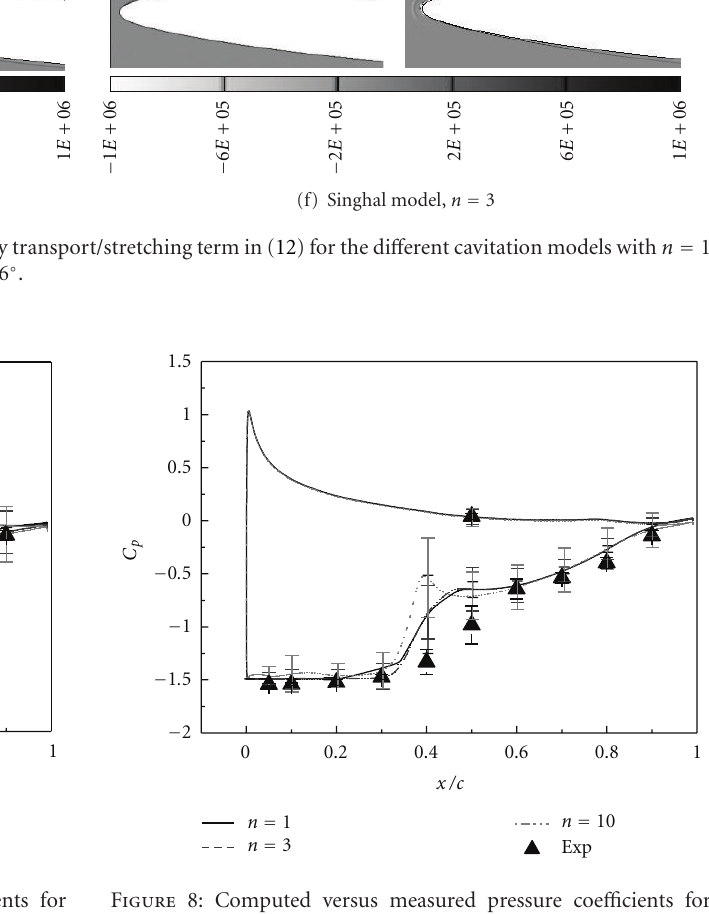
Figure 8: Computed versus measured pressure coe ffi cients for di ff erent n values, Merkle cavitation model, σ = 1 . 49, Re = 750,000, α = 6 ◦ . The lines represent the mean values and V ∞ = 5m/s, and the error bars represent the level of